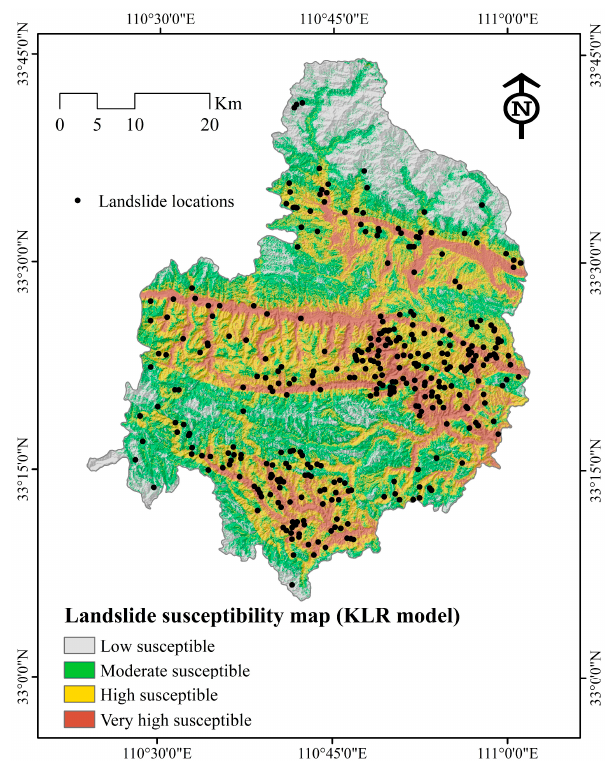
Figure 6. Landslide susceptibility map using the kernel logistic regression (KLR) model.